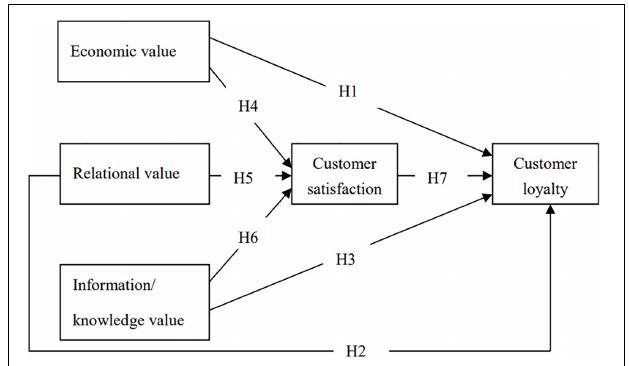
FIGURE 2 | Conceptual